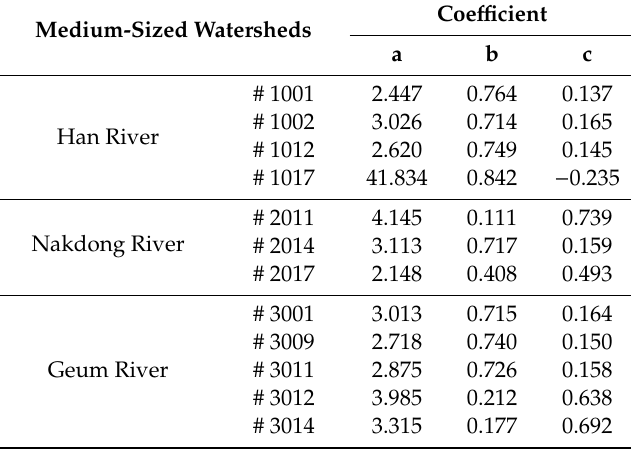
Table 2. Regression coe ffi cients for